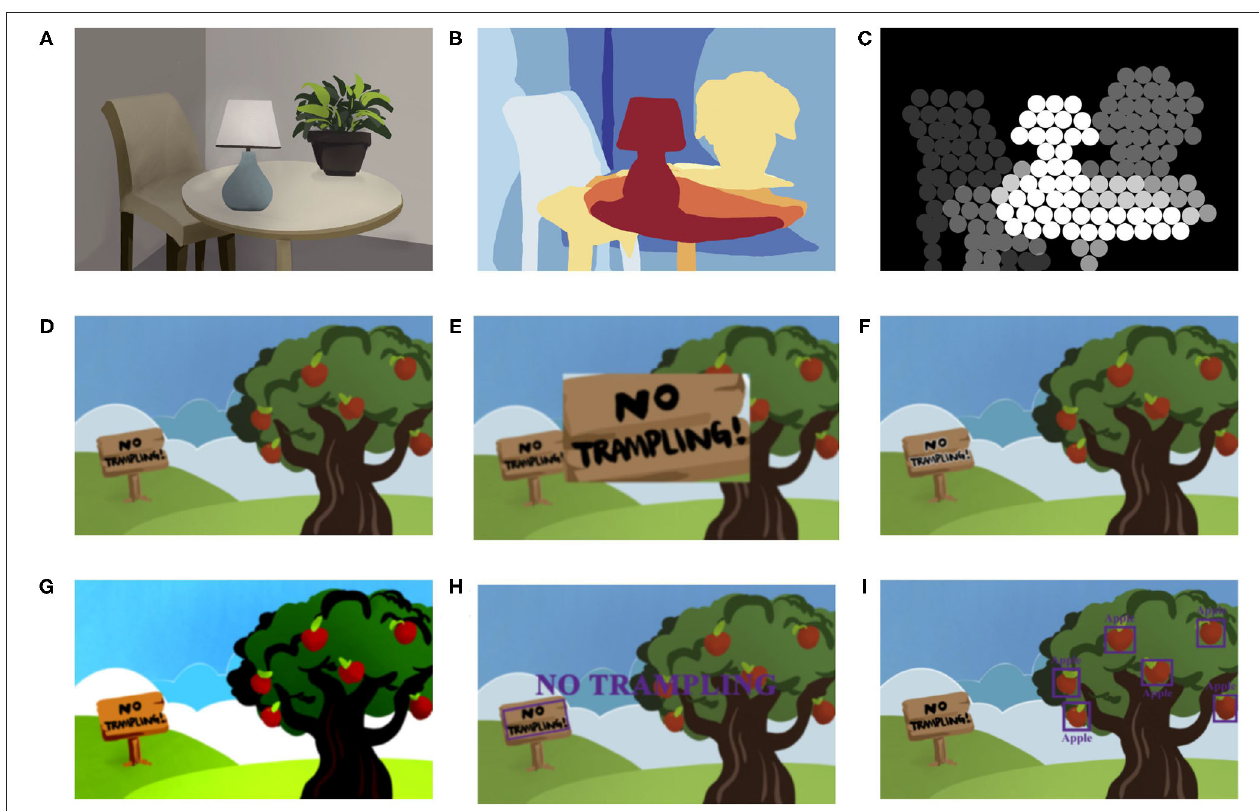
FIGURE 4 | Aiding the patients with low vision and blindness. (A–C) Illustrate using distance-based vision aid AR system to help the blind. (A) The natural scene. (B) The method using colors to indicate distances ( 37). The area in warmer colors indicates the closer distances, while the area in cooler colors indicates the farther. (C) The method using brightness to indicate distances (36). Brighter indicates closer distance while darker indicates farther. (D–I) Illustrate different methods to aid the patients with low vision ( 39). (D) The natural vision of patients with low vision. (E) The magnification method. (F) The edge enhancement method. (G) The contrast enhancement method. (H) The text extraction method. (I) The object recognition